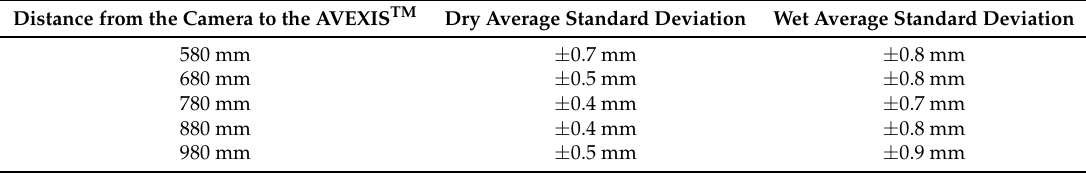
Table 2. Overall precision of the system at various distances to the camera during the wet and dry tests. Distance from the Camera to the AVEXIS